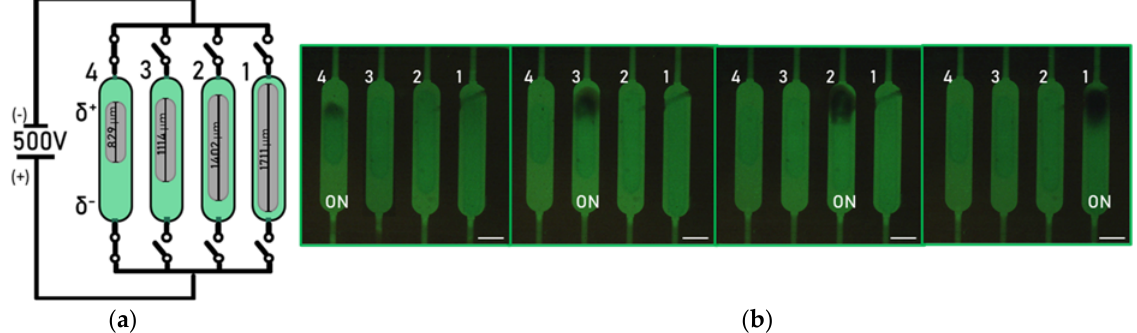
Figure 5. ( a ) Schematic (not to scale) of the experiments performed using the Pt electrodes in the chambers independently. The PDMS valves are represented by switches. The open configuration of the valve corresponds to a closed switch, thus the current can go through the chamber. ( b ) Fluores- cence micrographs showing the activity of the BPEs used individually upon the application of an external driving potential E tot = 500 V. The change in the fluorescence intensity reflects the decrease in the pH of the solution, due to the O 2 production via water electrolysis reaction. The electrodes are used independently thanks to the presence of PDMS valves, which can act as insulators by closing the conductive path through the channels. Scale bars: 350 µ